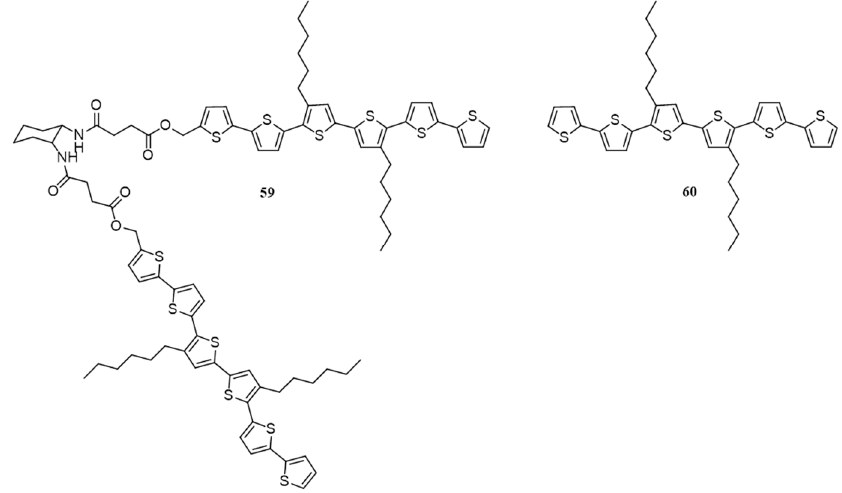
Figure 22. Chemical structures of 59 and 60 synthesized by Stupp et al. [83].